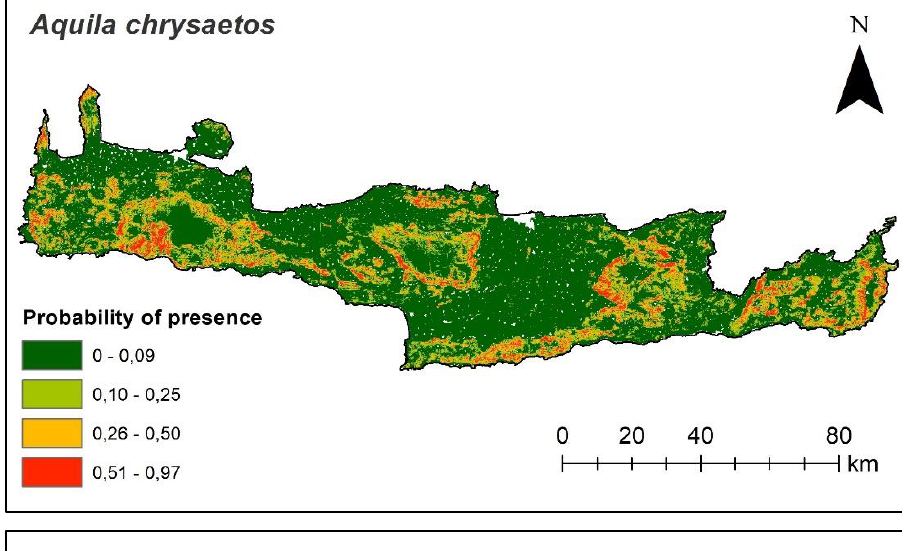
8 of 14 Table 4. Results of the binary logistic regression models investigating the factors that affect nest site selection by the Golden and the Bo nelli’s eagles on Crete. Variable